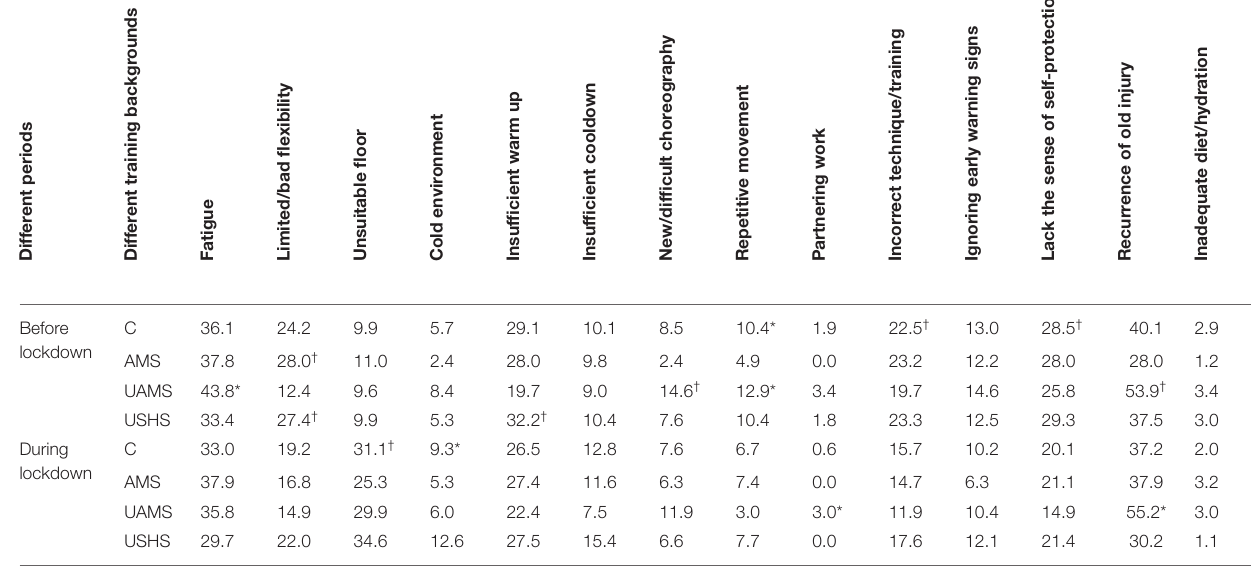
TABLE 6 | Injury causes in two periods